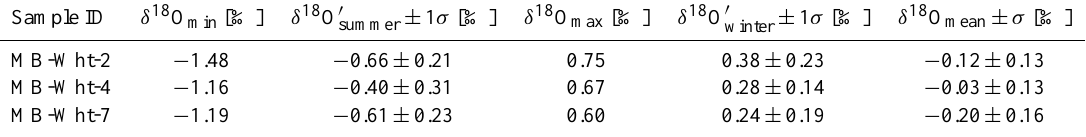
Table 2. Oxygen isotope values ( δ 18 O vs. VPDB) of the three Glycymeris planicostalis shells analyzed in this study. The table lists seasonal extremes ( δ 18 O min and δ 18 O max ) as well as average summer ( δ 18 O (cid:48) summer ; re-sampled values; explanation see text) and winter extremes values ( δ 18 O (cid:48) winter